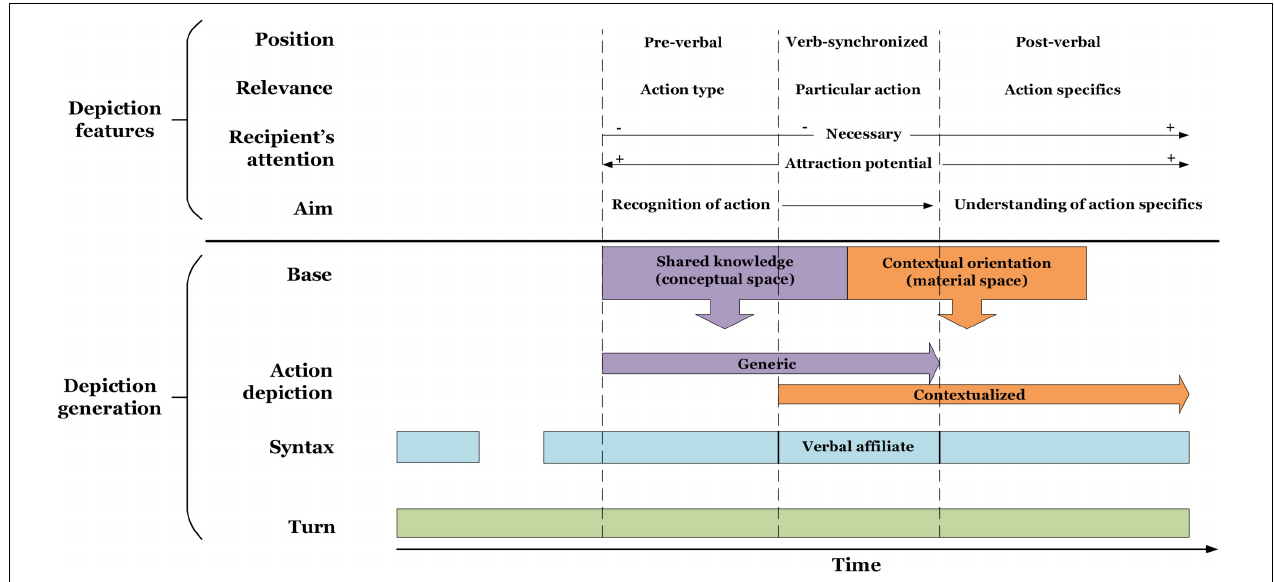
Figure 5 | Temporal alignment of action-depicting gestures and speech in the